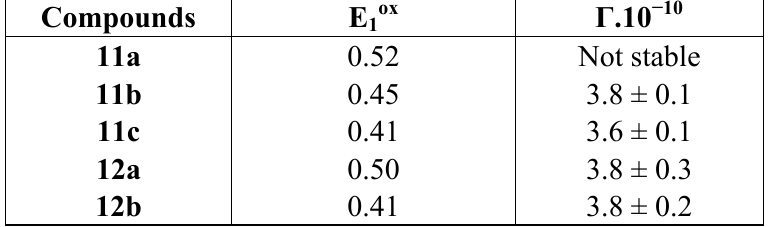
Table 1. Redox potentials ( E 1ox ) a and covering rate ( Γ ) a for SAMs of immobilized 11a–c and 12a , b